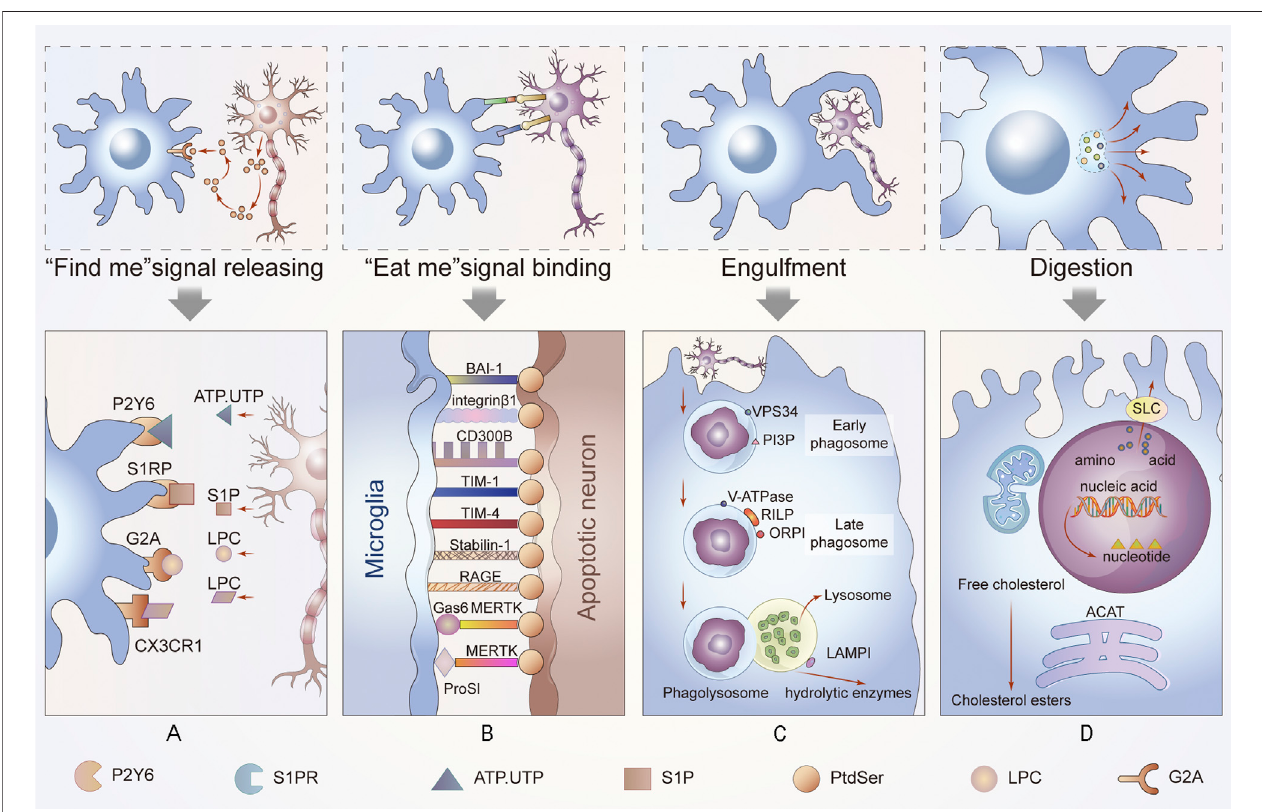
FIGURE2| Processofefferocytosis and related changes.In thispart ofthediagram, weshow thegeneralprocess ofefferocytosis in thenervoussystem. Aseries of molecules attract phagocytes to ACs and bind to them, and the membranes of the microglia, the resident phagocytes of the CNS, then stretch out and wrap around apoptotic neurons or glia until they are engulfed. The dead cells are gradually digested and excreted in the maturing phagosomes. This process is accompanied by energy metabolism and anti-in fl ammatory metabolism. (A) Newly ACs, still morphically normal, emit a “ fi nd me ” signal that binds to different receptors on nearby microglia,enticingthesecellstomigratetoACstoperformtheirfunction. (B) WhenmicrogliacomeintocontactwithACs,theyinteractwithcellreceptorsthatfunctionas “ eat me ” or “ do not eat me ” signals to determine their subsequent function. (C) Phagosomes gradually mature until they bind to lysosomes. This process is carried out under the premise of vps34, phosphotidylinositol-3-phosphate (PI3P) and Rab protein activation. Additionally, the acidity of the phagosome increases. (D) Finally, the contents of phagocytes are degraded or discharged after treatment in different ways. If cholesterol is esteri fi ed into cholesterol esters, amino acids are discharged throughthesolutecarrierfamily.Theseprocessesarealsoaccompaniedbychangesinintracellularenergyorotheraspectsofmetabolism,suchasmitochondrial fi ssion and fusion.